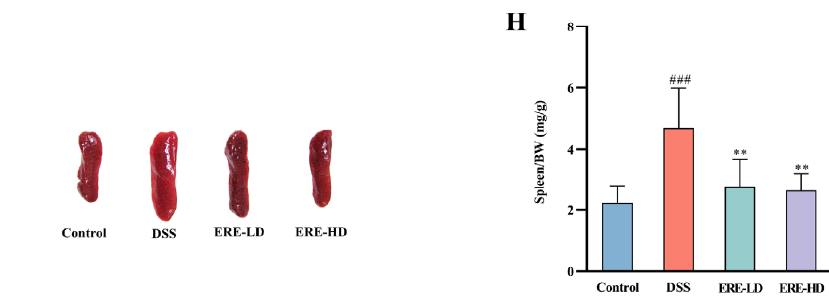
Figure 6. Effects of ERE on DSS-induced UC mice. The percentage of body weight change during DSS treatment ( A ). The total weight loss relative to the baseline value at day 0 ( B ). Disease activity index (DAI) scores calculated during DSS treatment ( C ). Representative photographs of feces before and after DSS treatment ( D ). Representative photos of colons € and the colon length in different groups ( F ). Representative photos of spleens ( G ) and the spleen/BW ratios in different groups ( H ). The values are expressed as the mean ± S.D.: * p < 0.05 compared with DSS group; ** p < 0.01 compared with DSS group; ### p < 0.001 compared with control group.